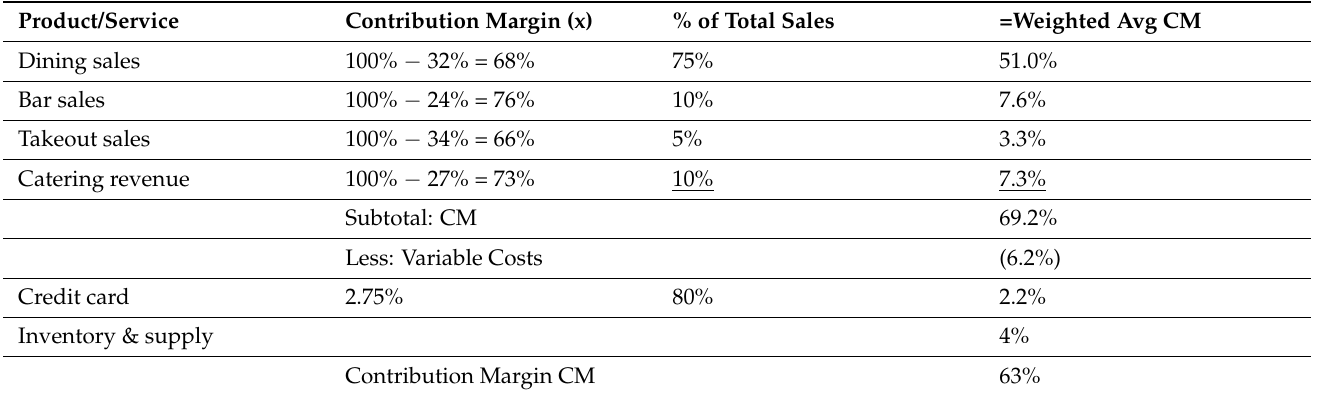
Table 4. Breakeven analysis. These are a composite of the sales statistics of three actual restaurants located in Long Island, New